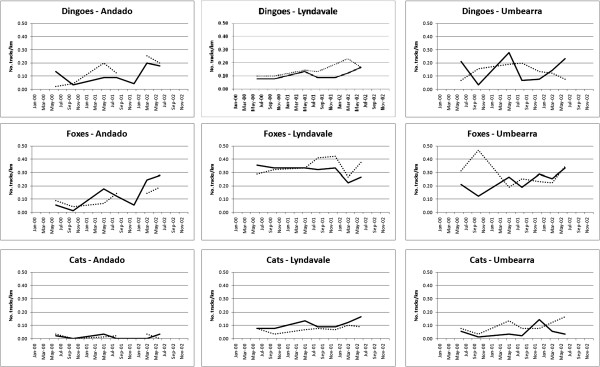
Abundance trends of dingoes, foxes and cats in paired baited (solid lines) and unbaited (dotted lines) treatment areas at three sites in central Australia (adapted from [48]), showing no evidence of mesopredator release following dingo control.